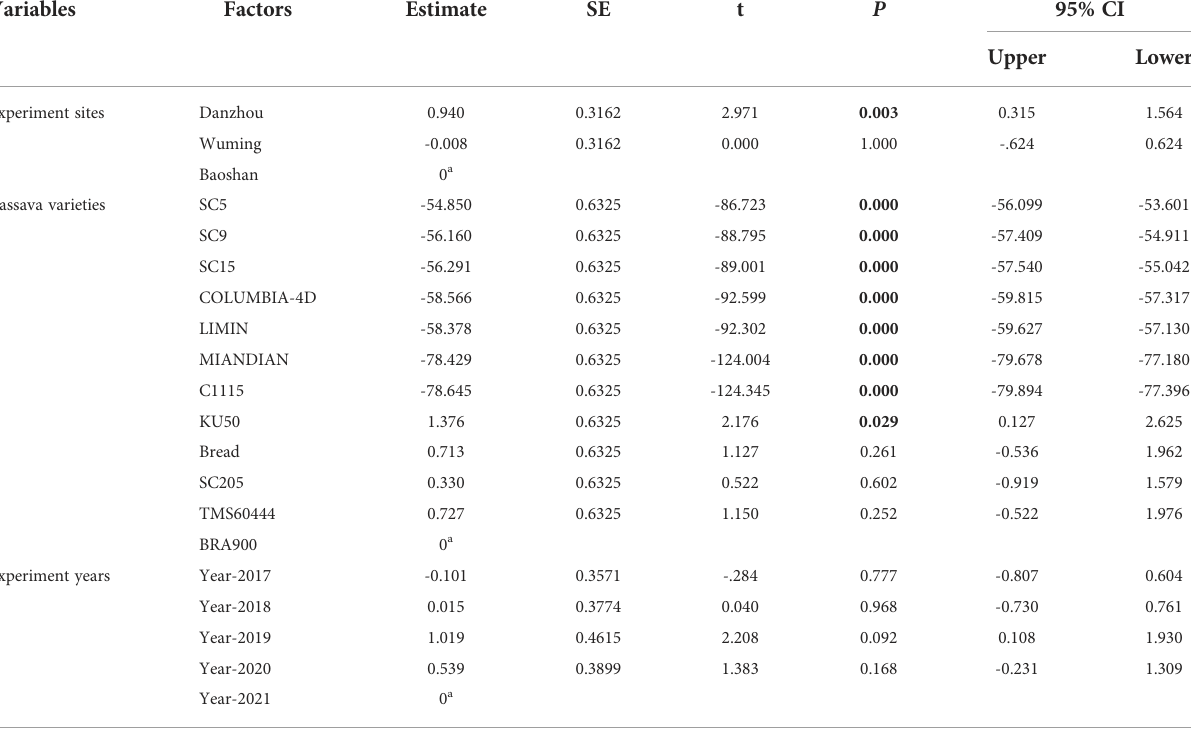
TABLE 2 Generalized linear mixed model (GLMM) evaluating the effect of experiment sites, cassava varieties, and experiment years on mite damage index.